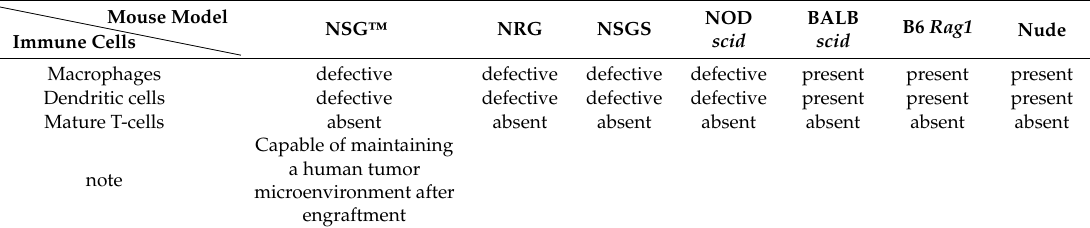
Table 5. Tumor- and chronic inflammation-relevant immune cells in di ff erent immunodeficient mouse models